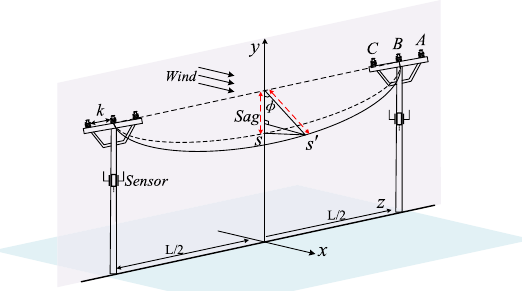
Fig. 10 Magnetic field waveform and synthetic trajectory of each axis